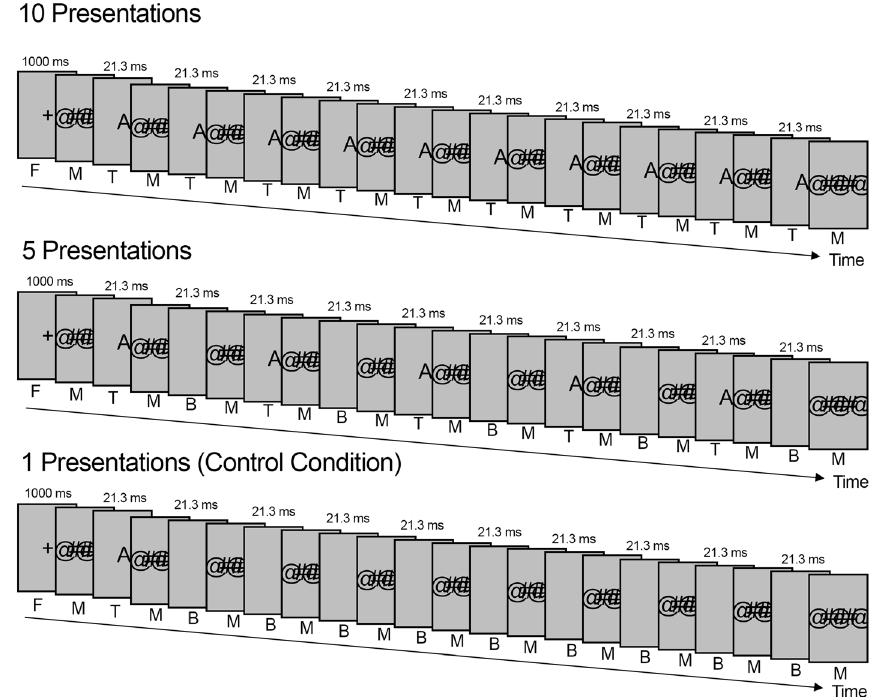
Figure 1. Procedure for Experiment 1. A focus signal (F) was shown followed by a series of masks (M), target letters (T), and blanks (B). The mask duration was adjusted according to target repetition-interval timings. (Experiment 2 added blank frames (7 ms) before and after the